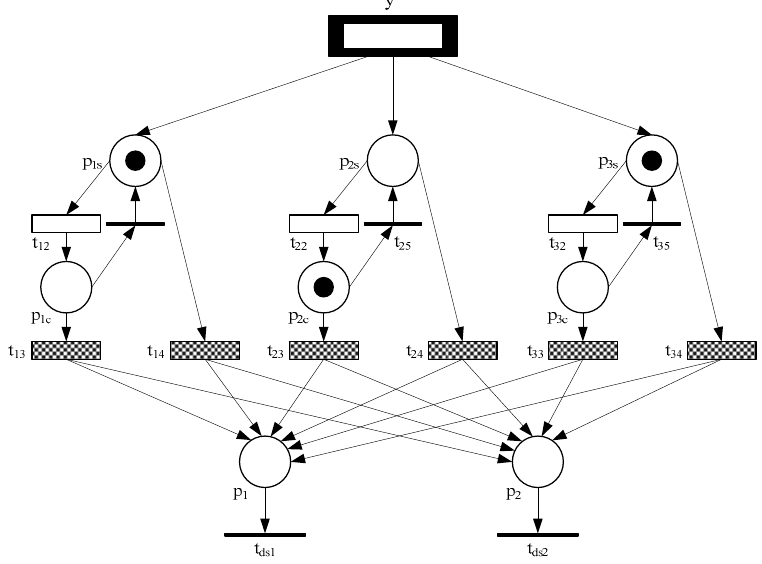
Figure 6. The PN model for a system with three charging tanks and two distillers.